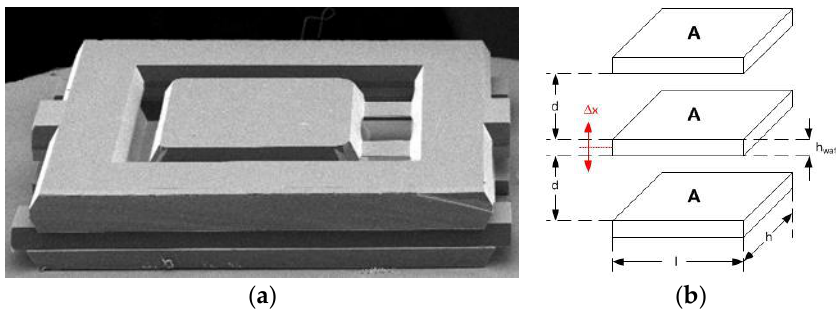
Figure 1. Accelerometer Vertical Design: ( a ) SEM image without top electrode; ( b ) Electrode scheme, including top electrode.